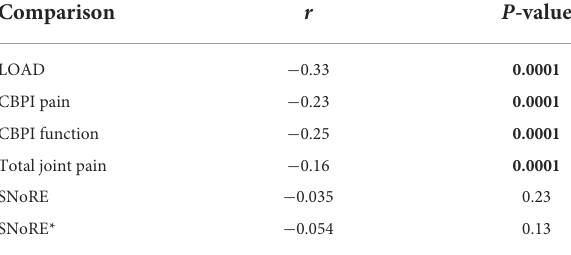
TABLE 8 Correlation between activity measured by the PetPace monitor (mean hourly activity counts), CMI scores, and total joint pain scores on Day